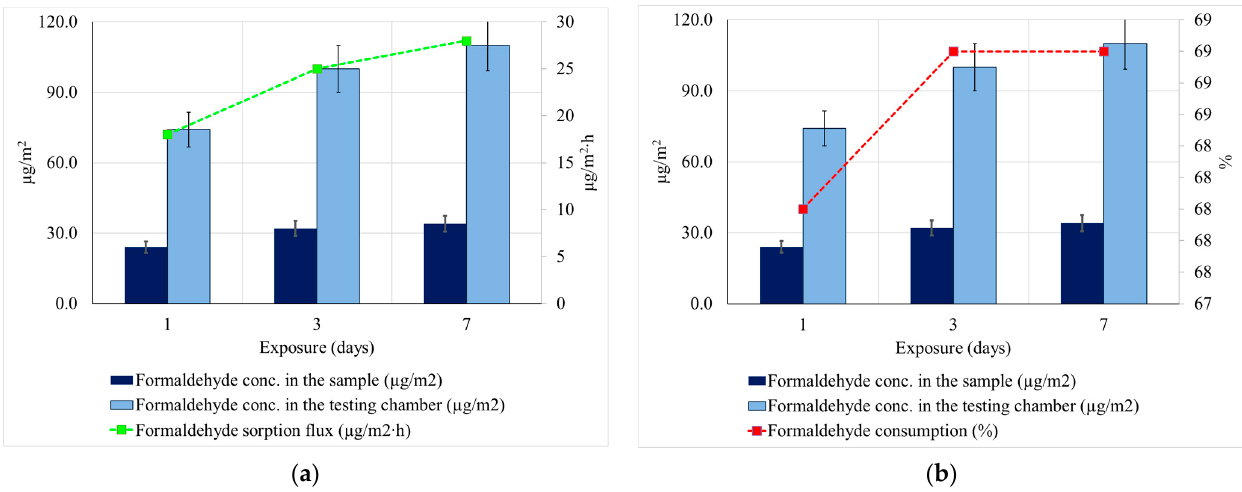
Figure 7. Capacity of the 44 mm thickness sheep wool thermal-insulating mattress on the sorption of formaldehyde. ( a ) Formaldehyde sorption flux (µg/m 2 h); ( b ) Formaldehyde consumption (%).